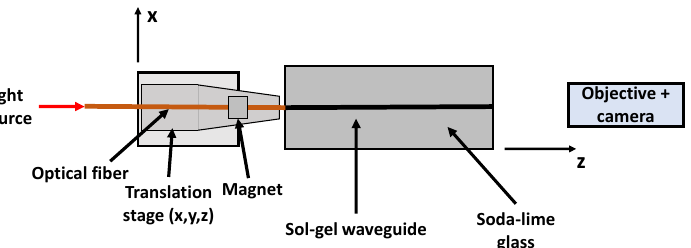
Figure 2. Setup used for the light injection (top-view). An SMF28 fiber is placed in a V-groove plat- form and fixed with magnets. The light injection, performed through a butt-coupling configuration, is optimized by moving the fiber in the X, Y, and Z directions. A camera (not shown here) records the top-view (XZ-plane) for optimal light injection while a second camera (on the right) is used for imaging the output light of the TiO 2 –SiO 2 sol-gel waveguides.